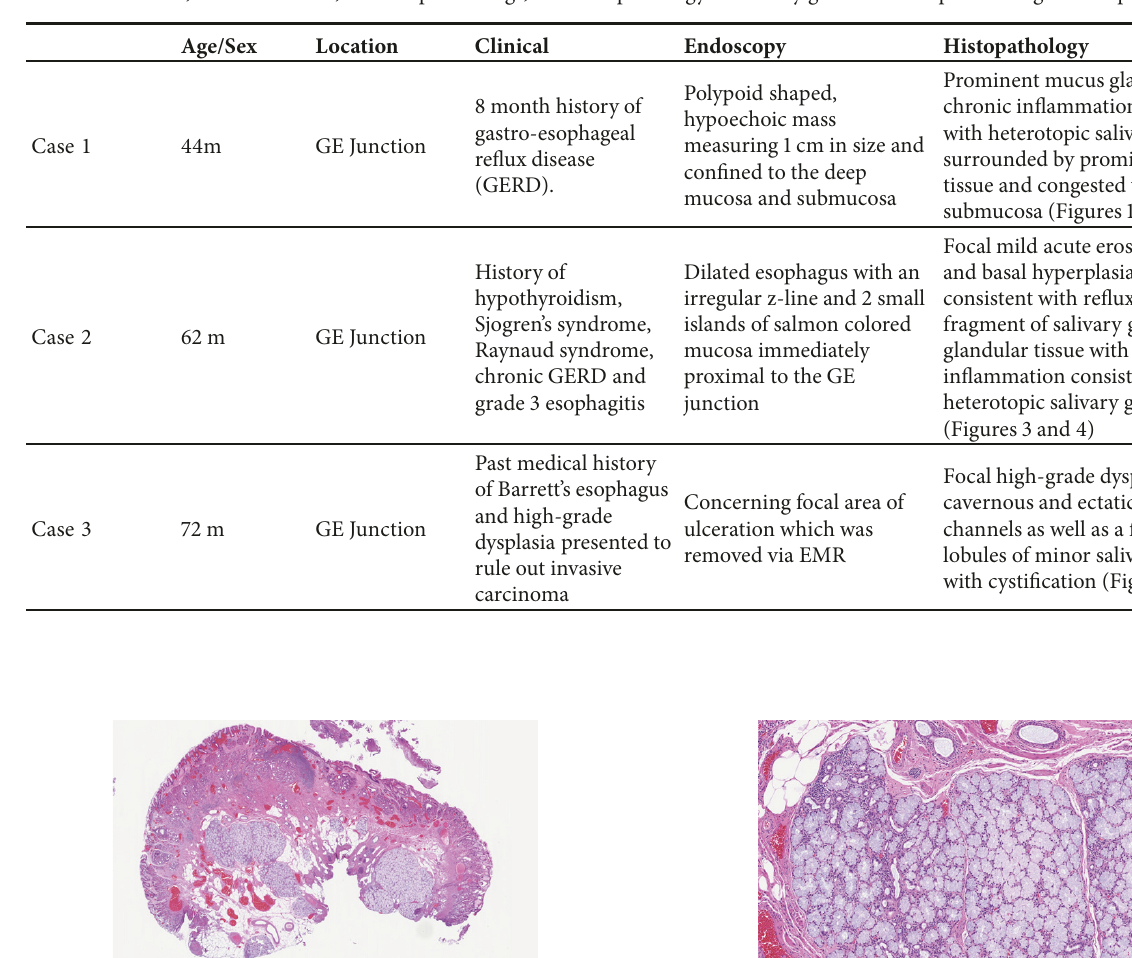
Table 1: Location, clinical features, endoscopic findings, and histopathology of salivary gland heterotopias at the gastroesophageal junction.